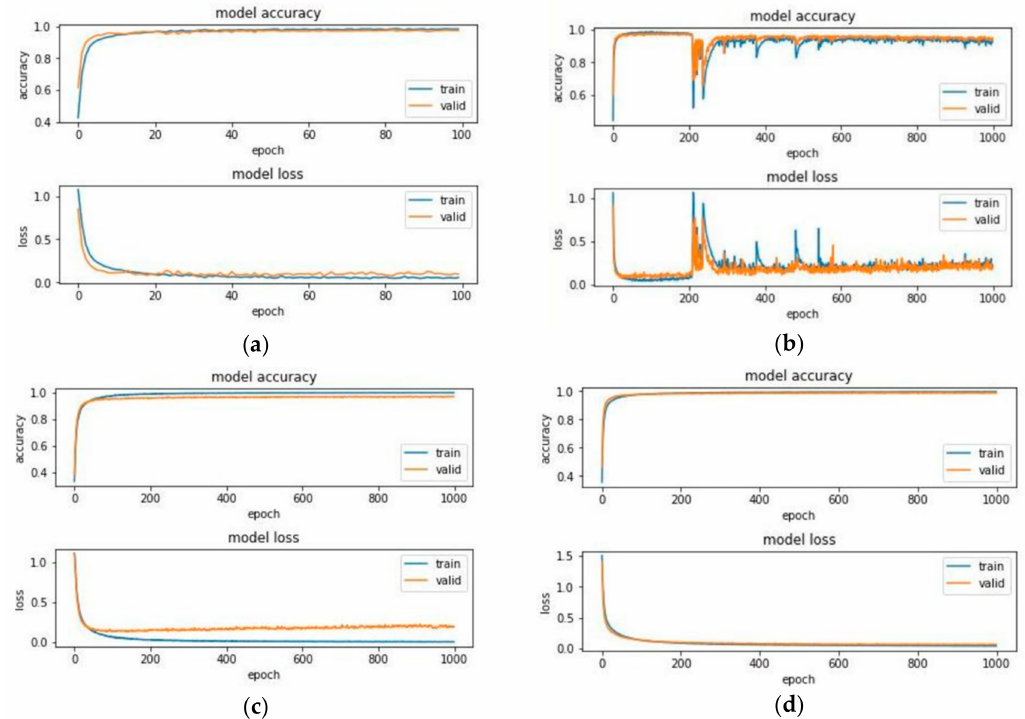
Figure 7. Graphs showing the e ff ect of hyperparameters on the training progress. ( a ) History of the model with 100 epochs, a batch size of 32, and a default learning rate of 0.001; ( b ) History of model with 1000 epochs, a batch size of 32, and a default learning rate of 0.001; ( c ) History of model with 1000 epochs, a batch size of 128, and a learning rate of 0.0001; ( d ) History of model with 1000 epochs, a batch size of 128, a learning rate of 0.0001, and an L2 weight decay value of